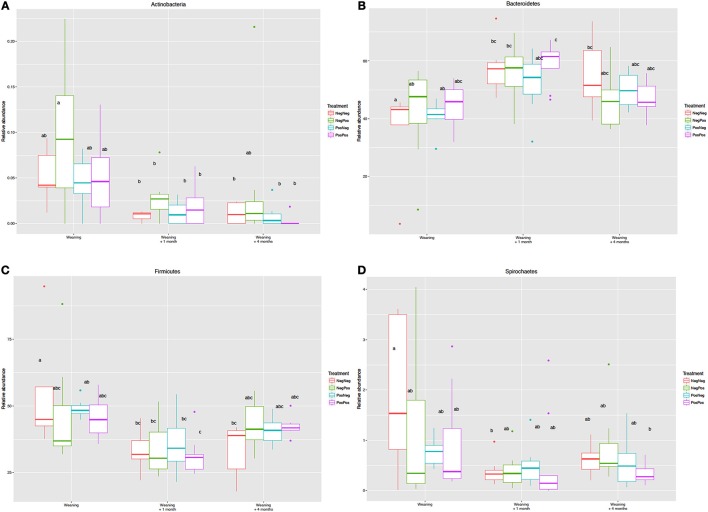
Relative abundance of the Phyla (A) Actinobacteria, (B) Bacteroidetes, (C) Firmicutes and (D) Spirochaetes in the different experimental groups at Weaning (W), Weaning + 1 month (W + 1), and Weaning + 4 months (W + 4) time points. Treatment groups: D–k– = NegNeg, D–k+ = NegPos, D+k– = PosNeg, D + k+ = PosPos. a,bLetters denote significant differences between groups, bars that do not share the same letter are significantly different from each other (P < 0.05).